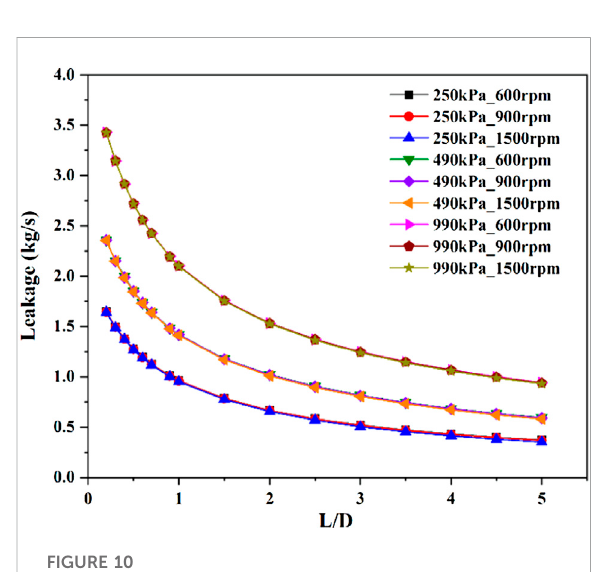
FIGURE 10 Thevariationsofleakage fl owrateswithlength-diameterratio under different pressure differences and rotational